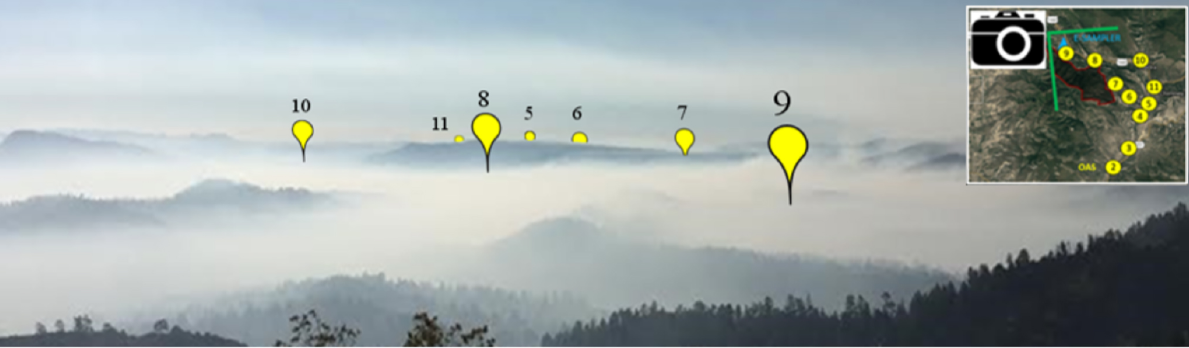
Figure 6. Smoke covering valley floors caused by an inversion on the morning of 17 September 2016. Photo taken from relay station 2.4km northwest of Vance Ranch (location 9) facing east (Photo courtesy of Columbine Wildfire